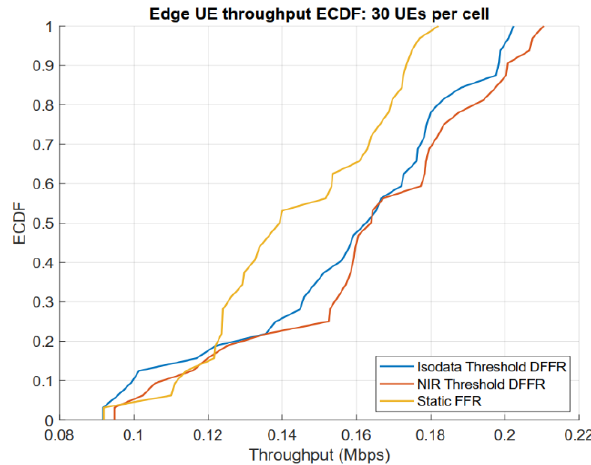
Figure 9. Edge UE throughput ECDF for 30 UEs per cell.